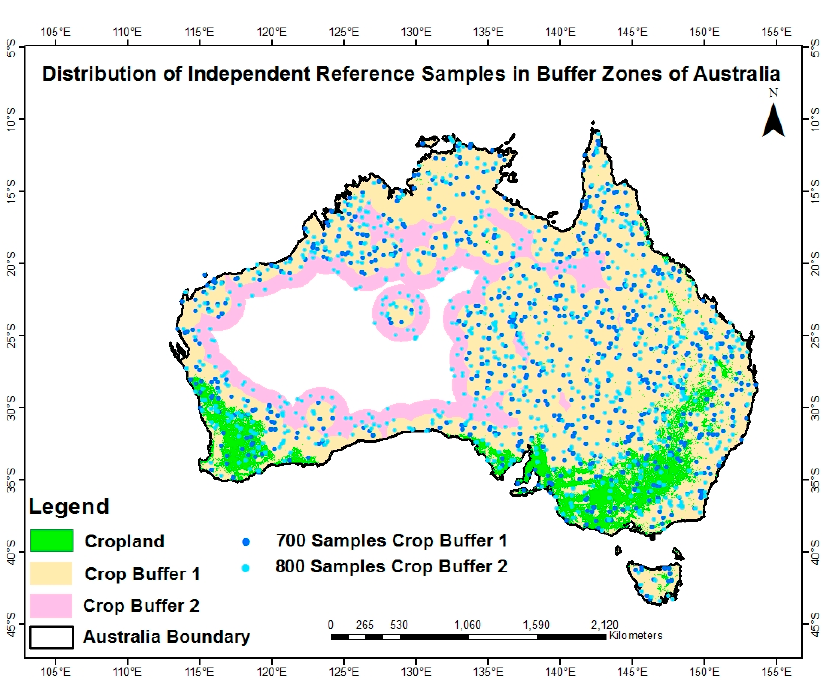
Figure 13. The distribution of reference samples in buffer zones of Australia.